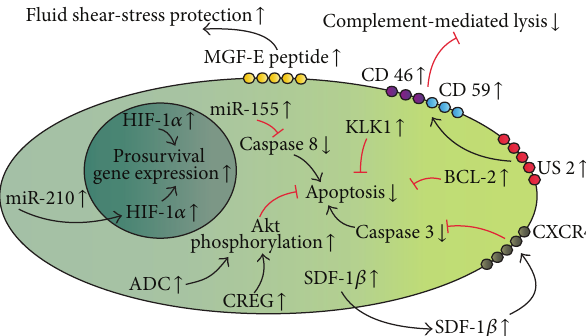
Figure 4: MSC prosurvival engineering. Prosurvival strategies primarily target the apoptosis process by downregulation of the elements involved in the apoptotic cascade (i.e., caspase 8 inhibition by miR-155). Other approaches involve the induction of prosurvival genes (i.e., HIF-1 𝛼 ), while still others ensure protection from fluid- stress or complement-mediated